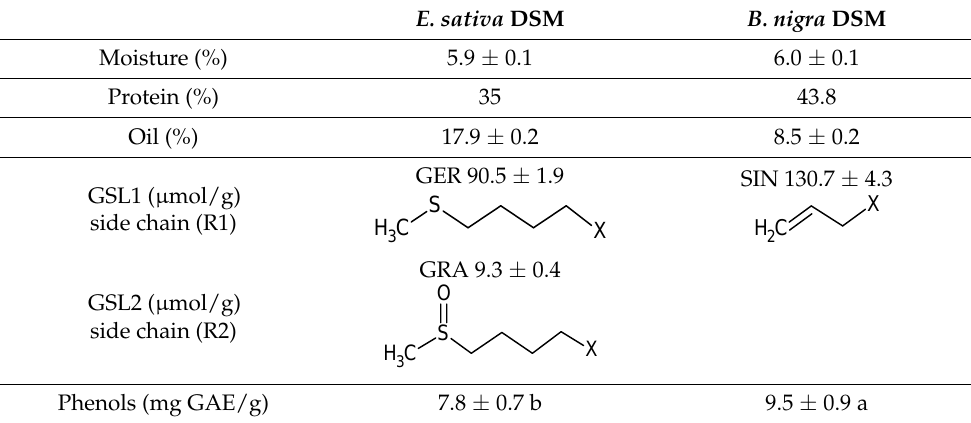
Table 1. Chemical characterization of E. sativa and B. nigra DSMs. Mean values ± standard deviation ( n = 3) are shown. GSL common variable side chain’s (R) chemical structure is also indicated, where X represents the GSL S-glucopyranosyl thiohydroximate moiety. GER, GRA and SIN indicate the GSL glucoerucin, glucoraphanin and sinigrin, respectively.